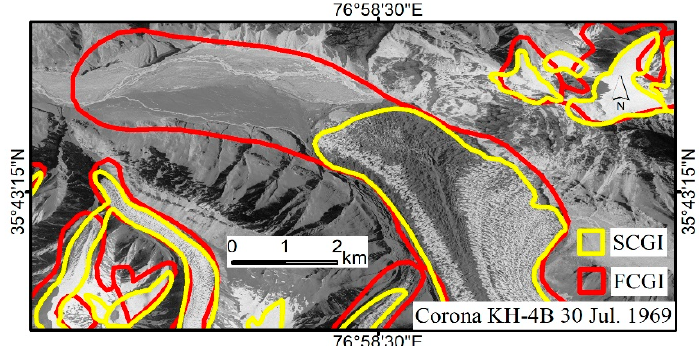
Figure 1. Example of overestimated glacier outlines by the First Chinese Glacier Inventory (FCGI). The overall location of this figure is shown in Section 2.1.